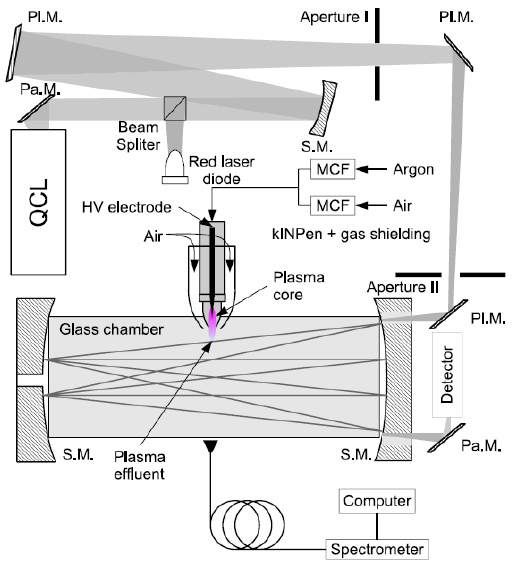
Figure 22. Schematic diagram of the spectroscopic experimental set-up based on a QCL absorption diagnostic system implementing the plasma jet. [54], © IOP Publishing. Reproduced with permission. All rights reserved. Photonics 2016 , 3 , 45